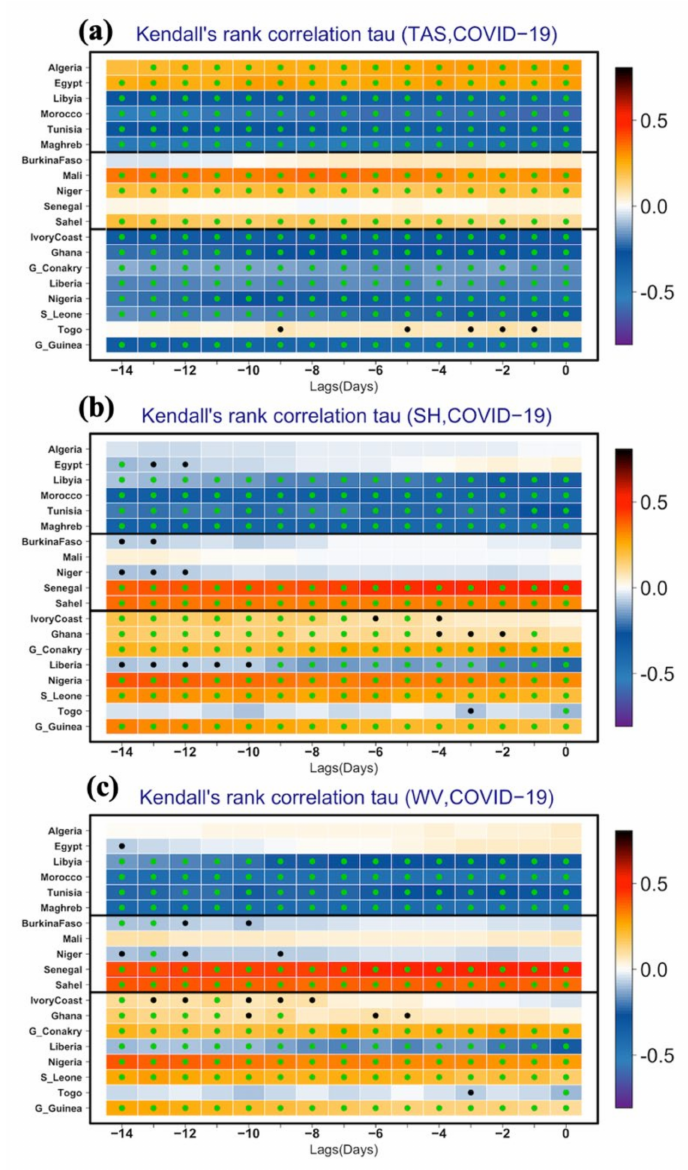
Figure 7. Kendall non-linear rank correlation ( τ ) test between the detrended anomaly of the meteoro- logical variables ( a – c ) and the residuals of COVID-19 cases over the selected northern and western African countries and area averages over the three climatic regions: the Maghreb, the Sahel, and the Gulf of Guinea. Significant correlations with 99% confidence intervals, that is, correlation that passed the Kendall rank tests at 0.01 level (i.e., p < 0.01; 99% CI), are reported in green dots, while correlations that passed the Kendall rank tests at 0.05 level (i.e., p < 0.05; 95% CI) are reported in black dots. The correlations are investigated against the residual of COVID-19 cases with a time-shift of 15 days (i.e., with a time-lag of − 14 days) to consider the incubation